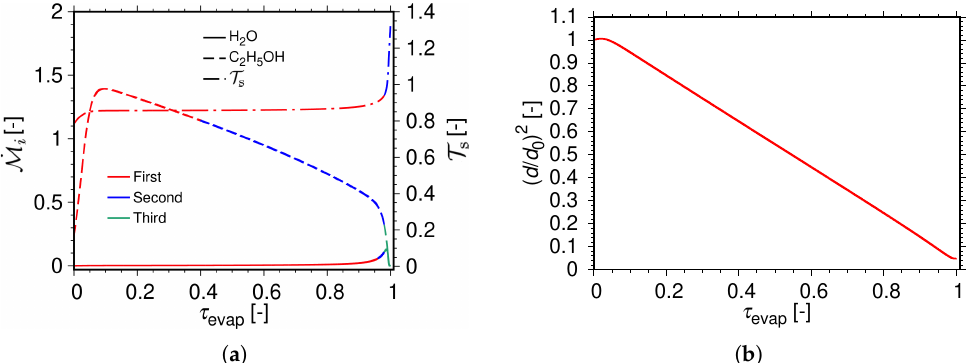
Figure 10. Fitted dimensionless profiles with normalized droplet evaporation time τ evap . T l,0 = 293.15 K, p = 1 bar, u 0 = 4 m/s and 8 m/s, T g,0 = 1200 K, Y C ( a ) Dimensionless mass evaporation rate and dimensionless droplet surface temperature with nor- malized vaporization time. ( b ) Normalized droplet surface area with normalized vaporization